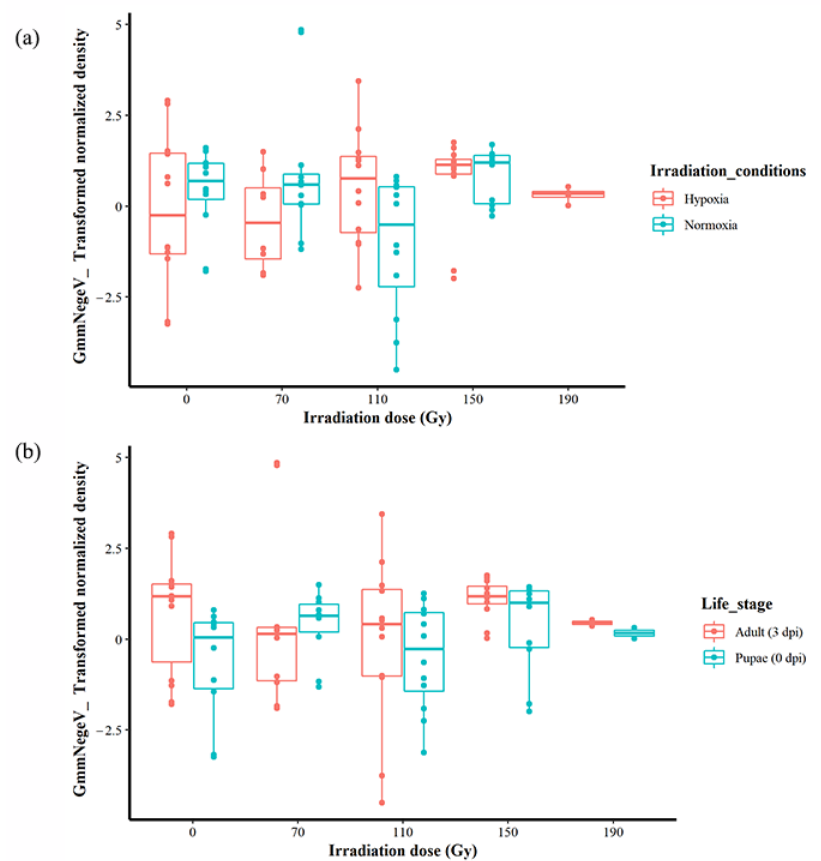
Figure 4. Effect of irradiation conditions and host life stage on the GmmNegeV densities after exposure to different irradiation doses in G. morsitans morsitans . ( a ) Effect of irradiation conditions re- gardless of host life stage. ( b ) Effect of host life stage regardless of irradiation conditions.